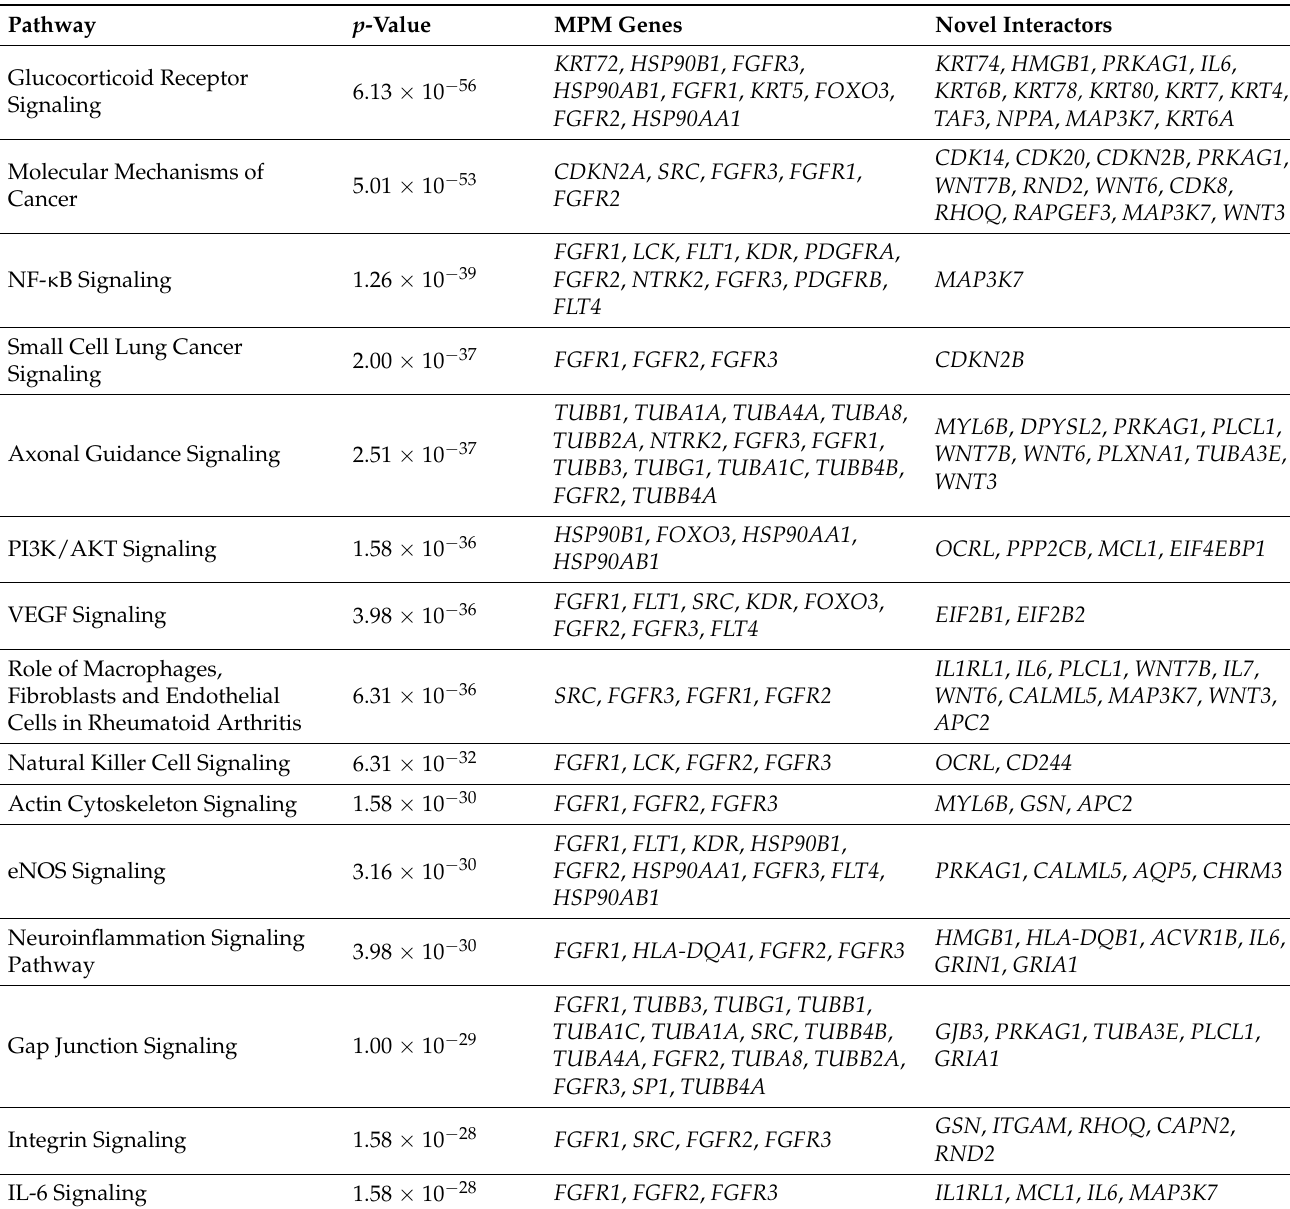
Table 2. Pathways that are relevant to the pathophysiology and genetics of malignant pleural mesothelioma: Pathway analysis revealed that molecular mechanisms underlying various types of cancers, axonal guidance signaling, PI3/AKT signaling, VEGF signaling, natural killer cell signaling and inflammation signaling pathways may be pertinent to the development of MPM. A list of all the associated pathways is shown in Data File